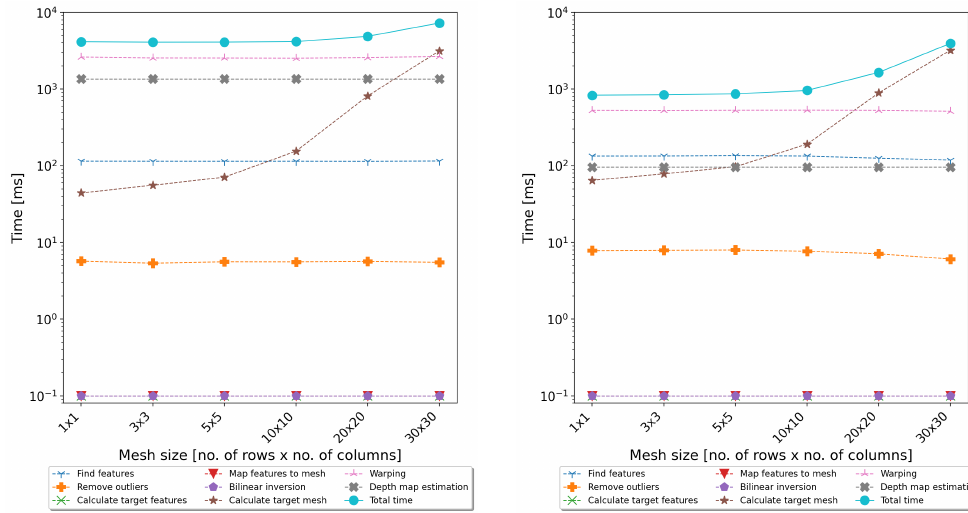
Figure 8. Results of the performance evaluation using the notebook computer—execution time of individual steps of the algorithms on a CPU ( left ) and GPU ( right ).